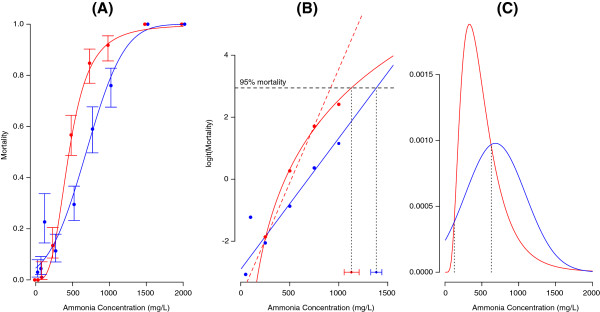
Acute toxicity of ammonia against larvae of Anopheles gambiae molecular forms.(A) Observed mortality (±95% confidence limits) after 12 hours exposure at increasing concentrations of ammonia (mg·L-1 total-N). The points and error bars corresponding to each molecular form are slightly shifted from each other for presentation purposes. Sigmoid curves represent the fitted minimal adequate regression lines plotted on the linear scale (red: S-form sites; blue: M-form sites), from which the lethal concentrations presented in Table 2 were calculated. (B) The same data of panel (A) drawn on the logit scale. The explanatory variable (i.e. ammonia concentration) of the minimal adequate logistic regression model for the S form (red curve) is log-transformed, hence the line plots as a curve because the abscissa on the graph is on the linear scale. The dotted red line represents the alternative model for the S-form data, with ammonia concentration expressed on the linear scale, as in the case of the M form (blue line); this regression line has been used for statistical inference purposes, to compare the functional response of the M form with respect to that of the S form (cf. Results). Diamonds at the bottom right of the scattergram indicate the estimated 95% lethal concentration (LC95 ± SE) for M-form sites (blue) and S-form sites (red). Data points for which observed mortality was 0% or 100% are not shown because they map to ± ∞ on the logit scale. (C) Probability density functions (PDF) of individual tolerance thresholds in populations of the two forms estimated from probit analysis (blue: M form, red: S form). Vertical dotted lines identify the ammonia concentration tolerance thresholds where the two PDF curves intersect; above or below these tolerance thresholds, the M population contains a greater proportion of individuals compared to the S form.